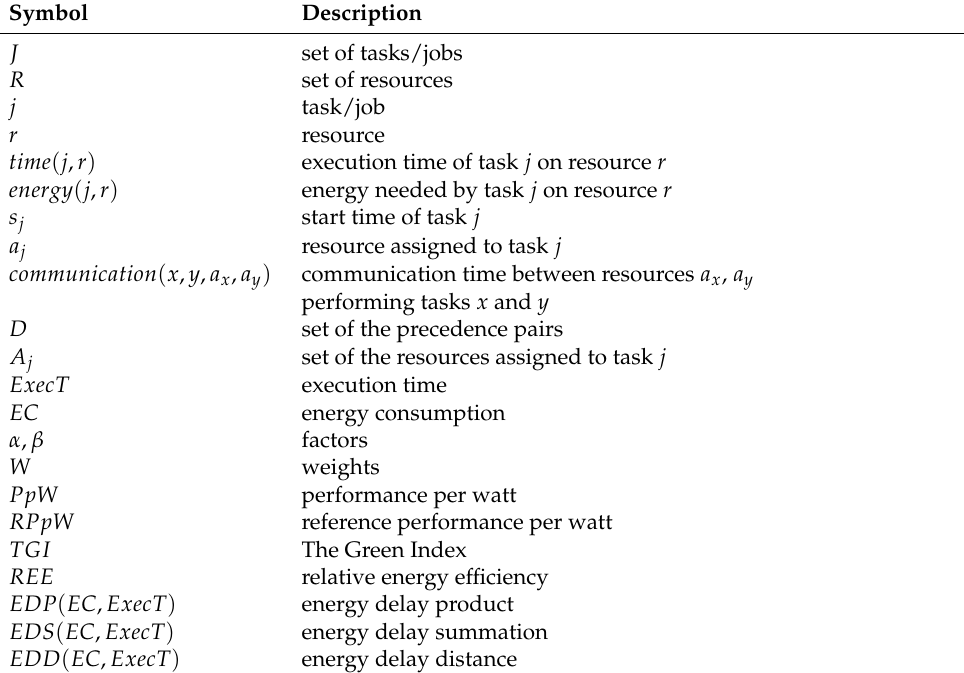
Table 1. Symbols used in the